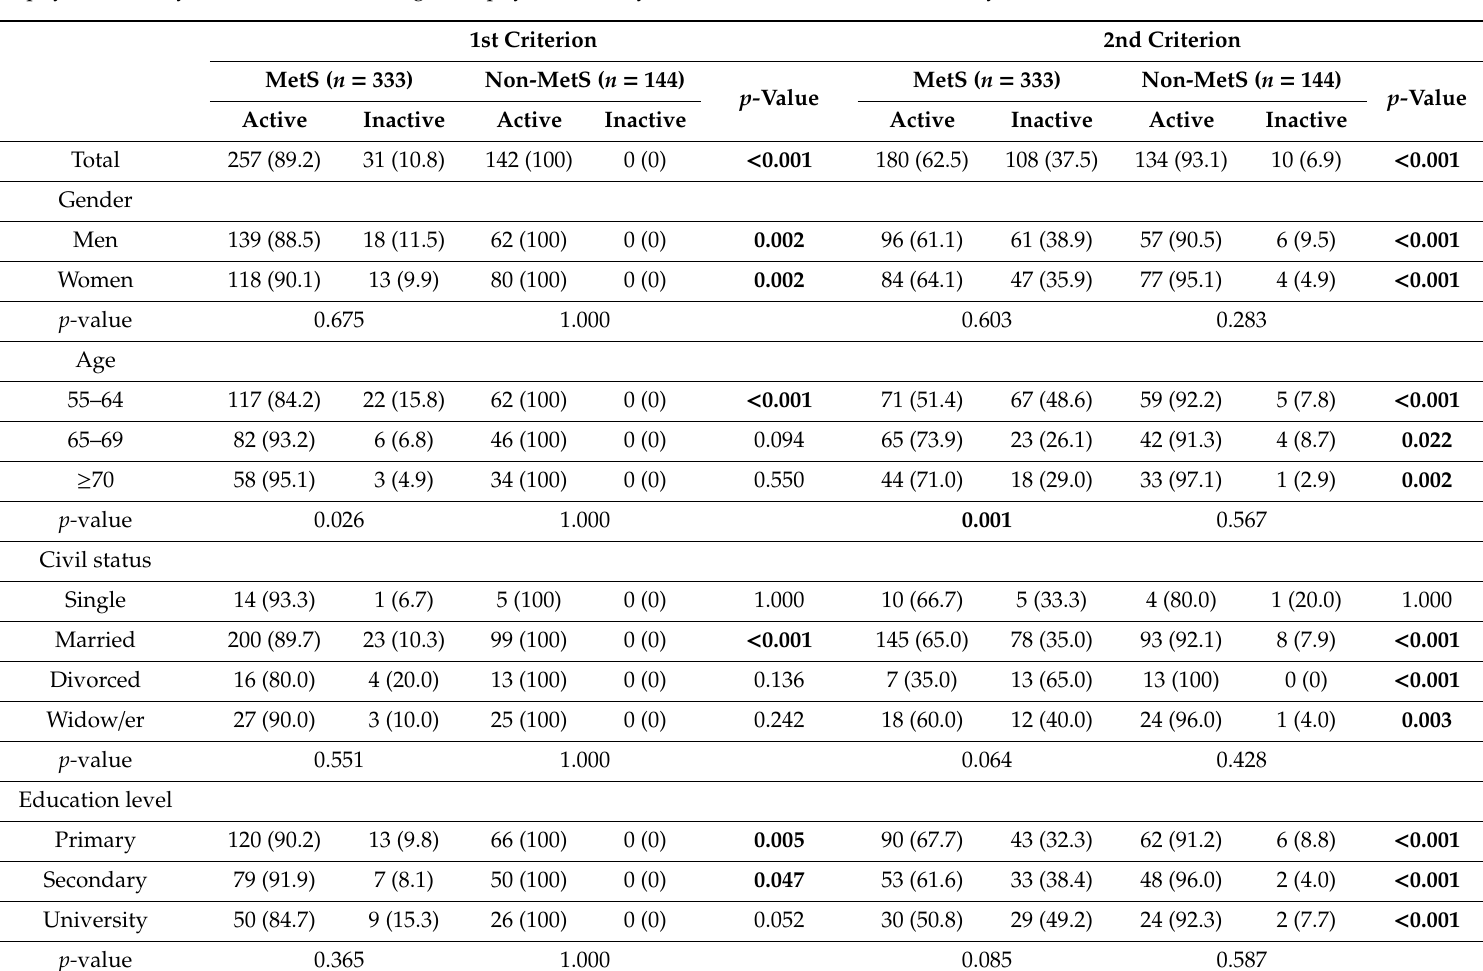
Table 3. Percentage of active and inactive population in MetS ( n = 288) and non-MetS ( n = 142) participants according to two criteria (1st Criterion: > 150 min / week